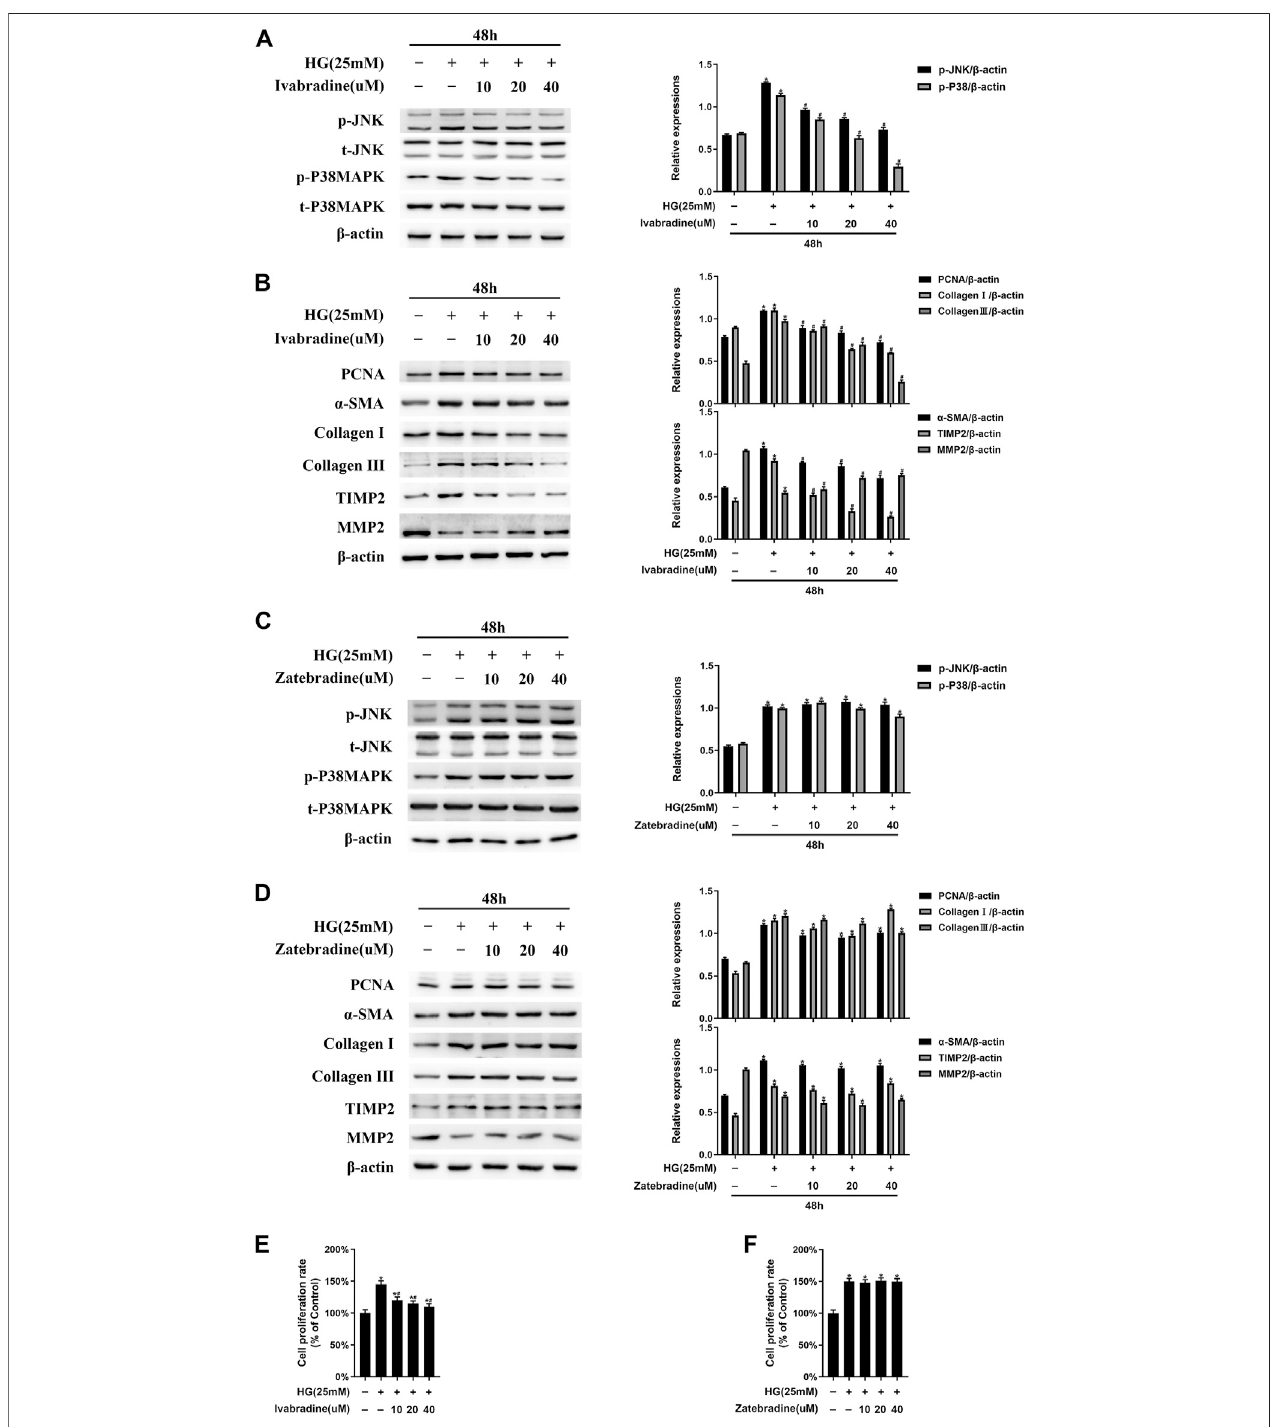
FIGURE4| Ivabradine,butnotzatebradine,reducesJNK/p38MAPKactivationandthehighglucose(HG)-inducedincreasein fi brogenicproteinexpression invitro (A) NRCFswerepretreatedwithorwithoutivabradineattheindicatedconcentrationsfor30 min,andthenexposedtoHGfor48 h.JNKandp38MAPKphosphorylation andtotalJNKandp38MAPKexpressionweredetermined bywesternblotting (B) NRCFsweretreatedasdescribed in (A) andtheproteinexpressionofPCNA, α -SMA, TIMP2, collagen I, collagen III, and MMP2 was determined by western blotting (C and D) NRCFs were pretreated with or without zatebradine at the indicated concentrationsfor30 min,andthenexposedtoHGfor48 h.Theproteins described in (A) and (B) werequanti fi edbywesternblotting (EandF) NRCFsweretreatedas described in (A) and (C) and the cell proliferation rate was determined using an MTT assay. Data are presented as mean ± SEM ( n (cid:2) 3). p -values were calculated using one-way ANOVA with Tukey multiple comparison test. * p < 0.05, compared to the normal group; # p < 0.05, compared to the HG group.